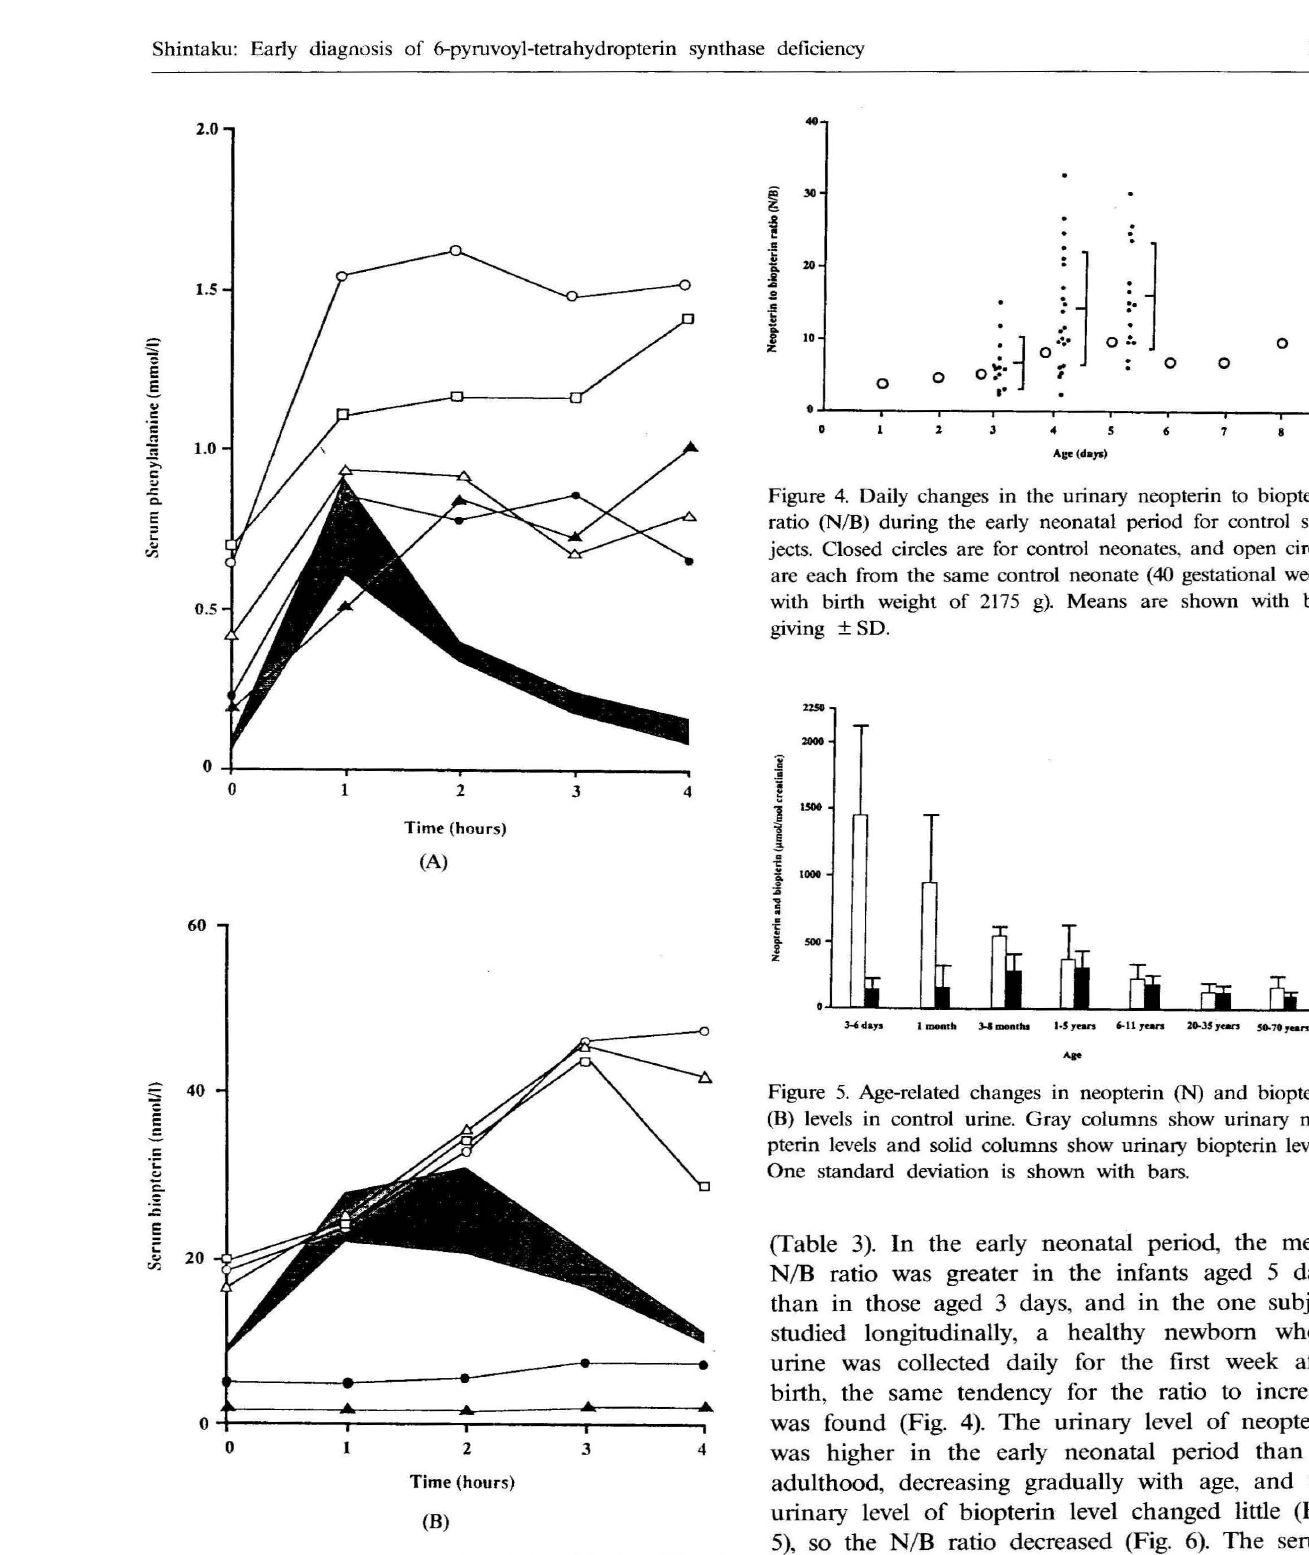
Figure 3 Response of serum levels of phenylalanine (A) and biopterin (B) to oral phenylalanine loading (100 mglkg) . • , Case I and ... , case 2 (BH4 deficiency). 0, Case 4 and 6 , case 5 (persistent hyperphenylalaninemia). 0, case 6 (classical PKU). The shaded area gives the control range for the sub stance being assayed; the results of the two sets of parents of cases I and 2 also were within this range.